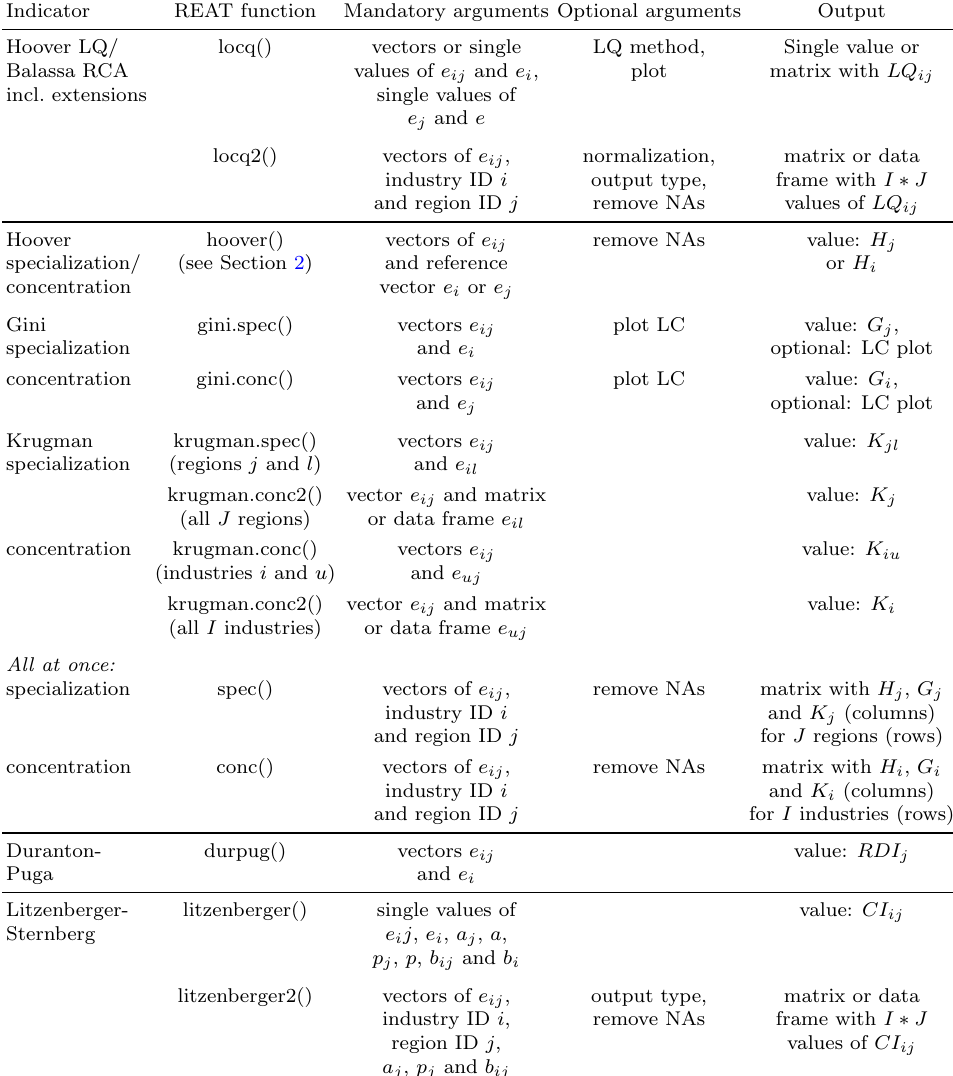
Table 7: REAT functions for regional specialization and industry